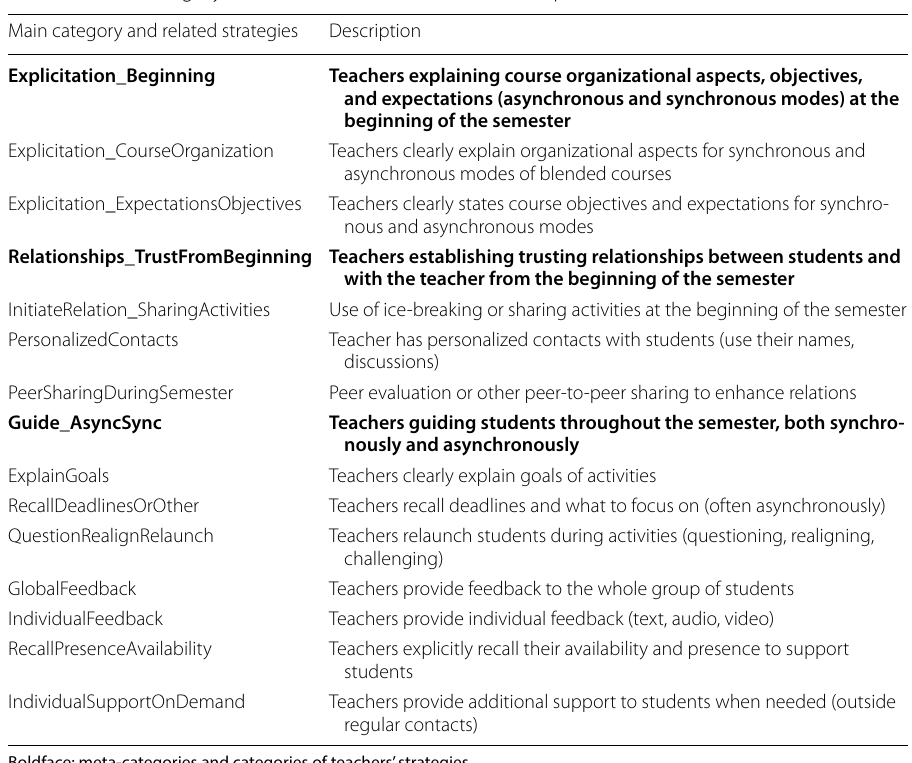
Table 5 Meta-category: teacher’s role and course relationships